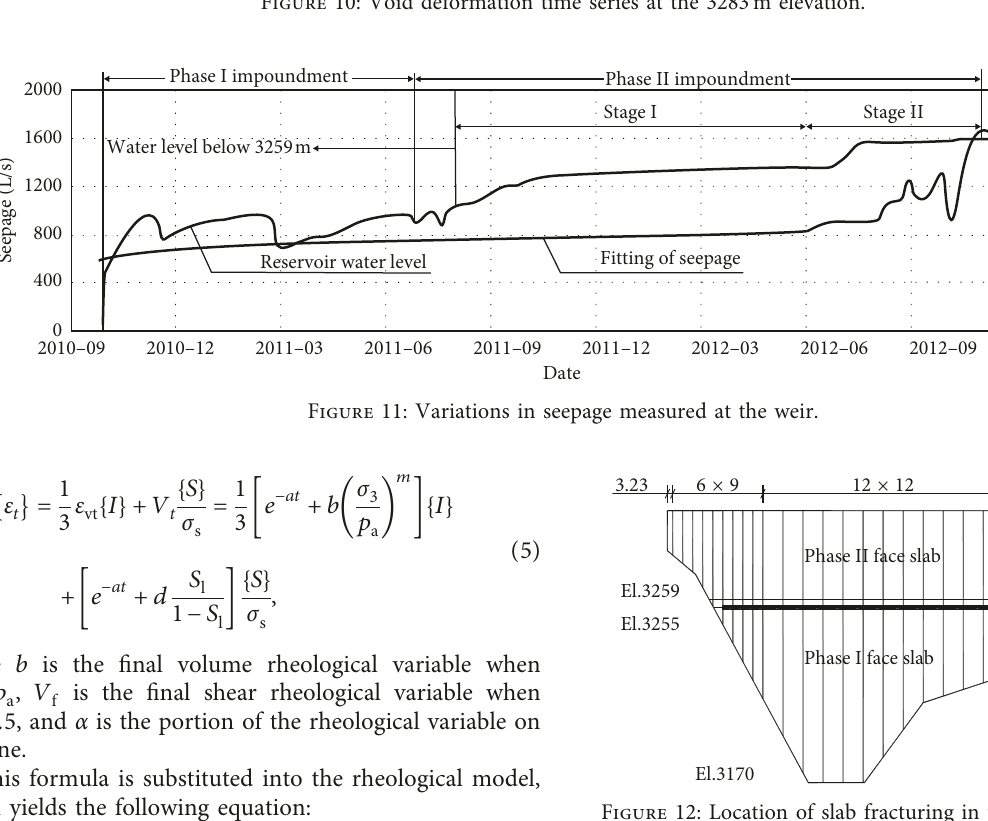
Figure 10: Void deformation time series at the 3283m elevation.